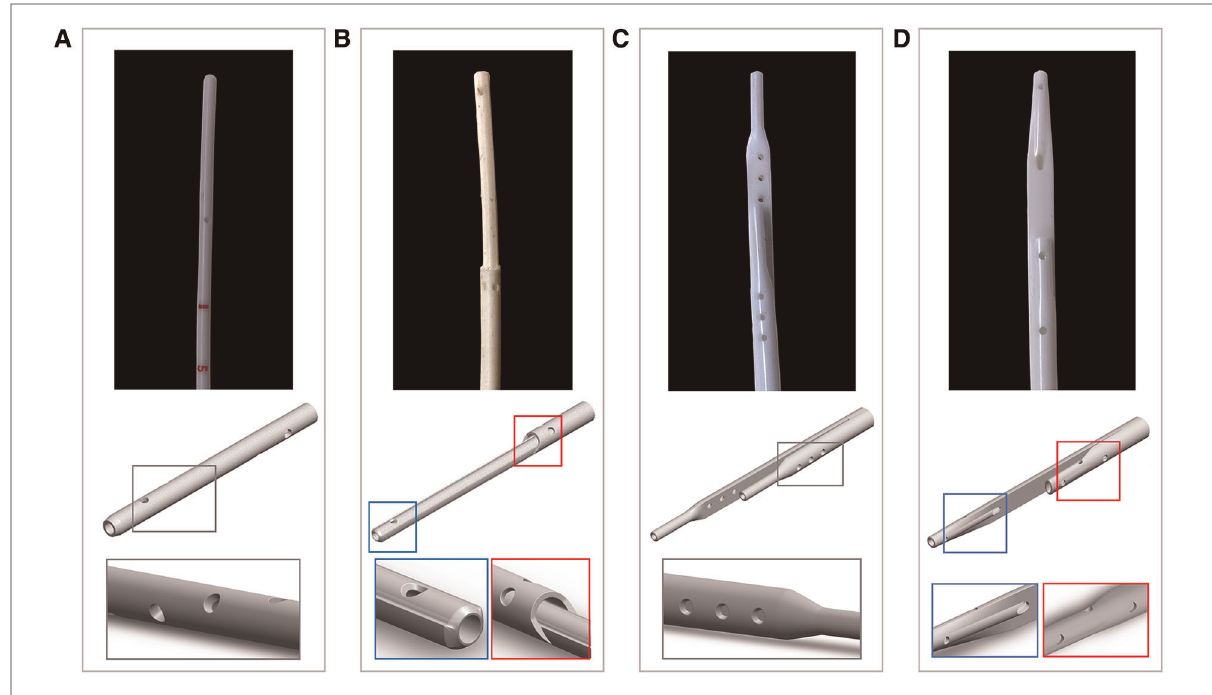
FIGURE 1 Photographs and CAD models of the CVLs included in this study with magni fi cation on the details of the side-holes: ( A ) Tesio (6.5 F); ( B ) Hemo-Cath (8 F); ( C ) Pediatric Split Cath (10 F); and ( D ) Split Cath III (14